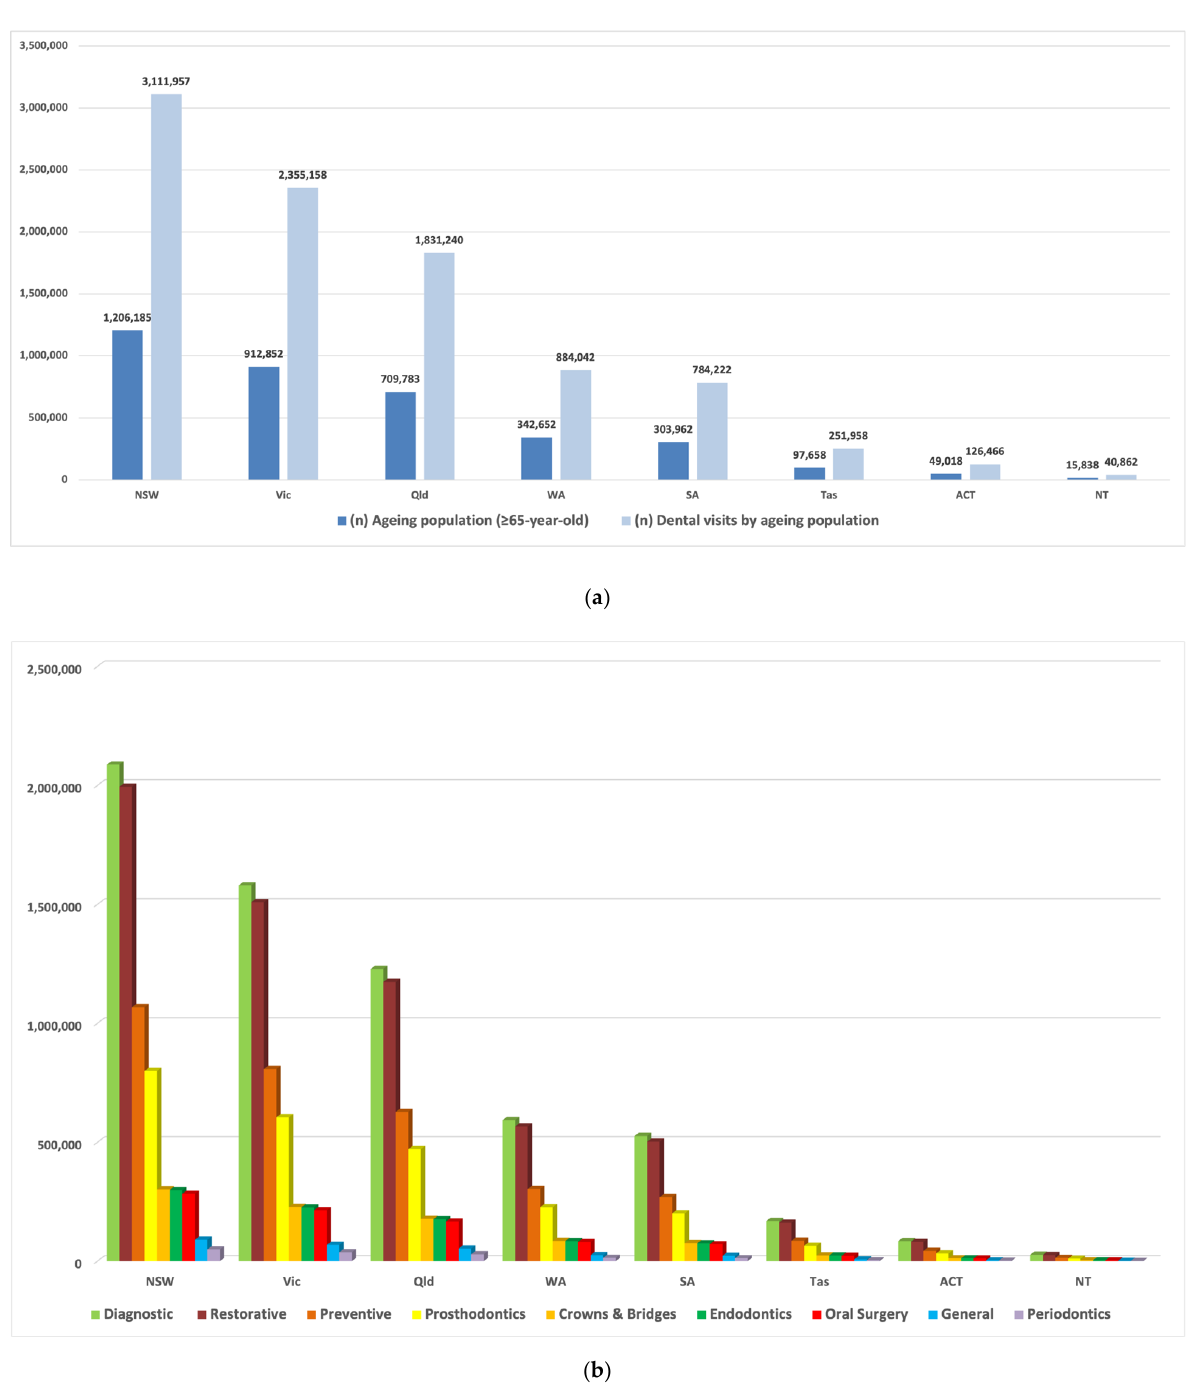
Figure 1. The number of dental visits received by people aged 65 and over, ( a ) The numbers across the states and territories of Australia, ( b ) The numbers by the type of the services. New South Wales (NSW); South Australia (SA); Victoria (Vic); Queensland (Qld); Tasmania (Tas) and Western Australia (WA), the Australian Capital Territory (ACT) and the Northern Territory (NT).